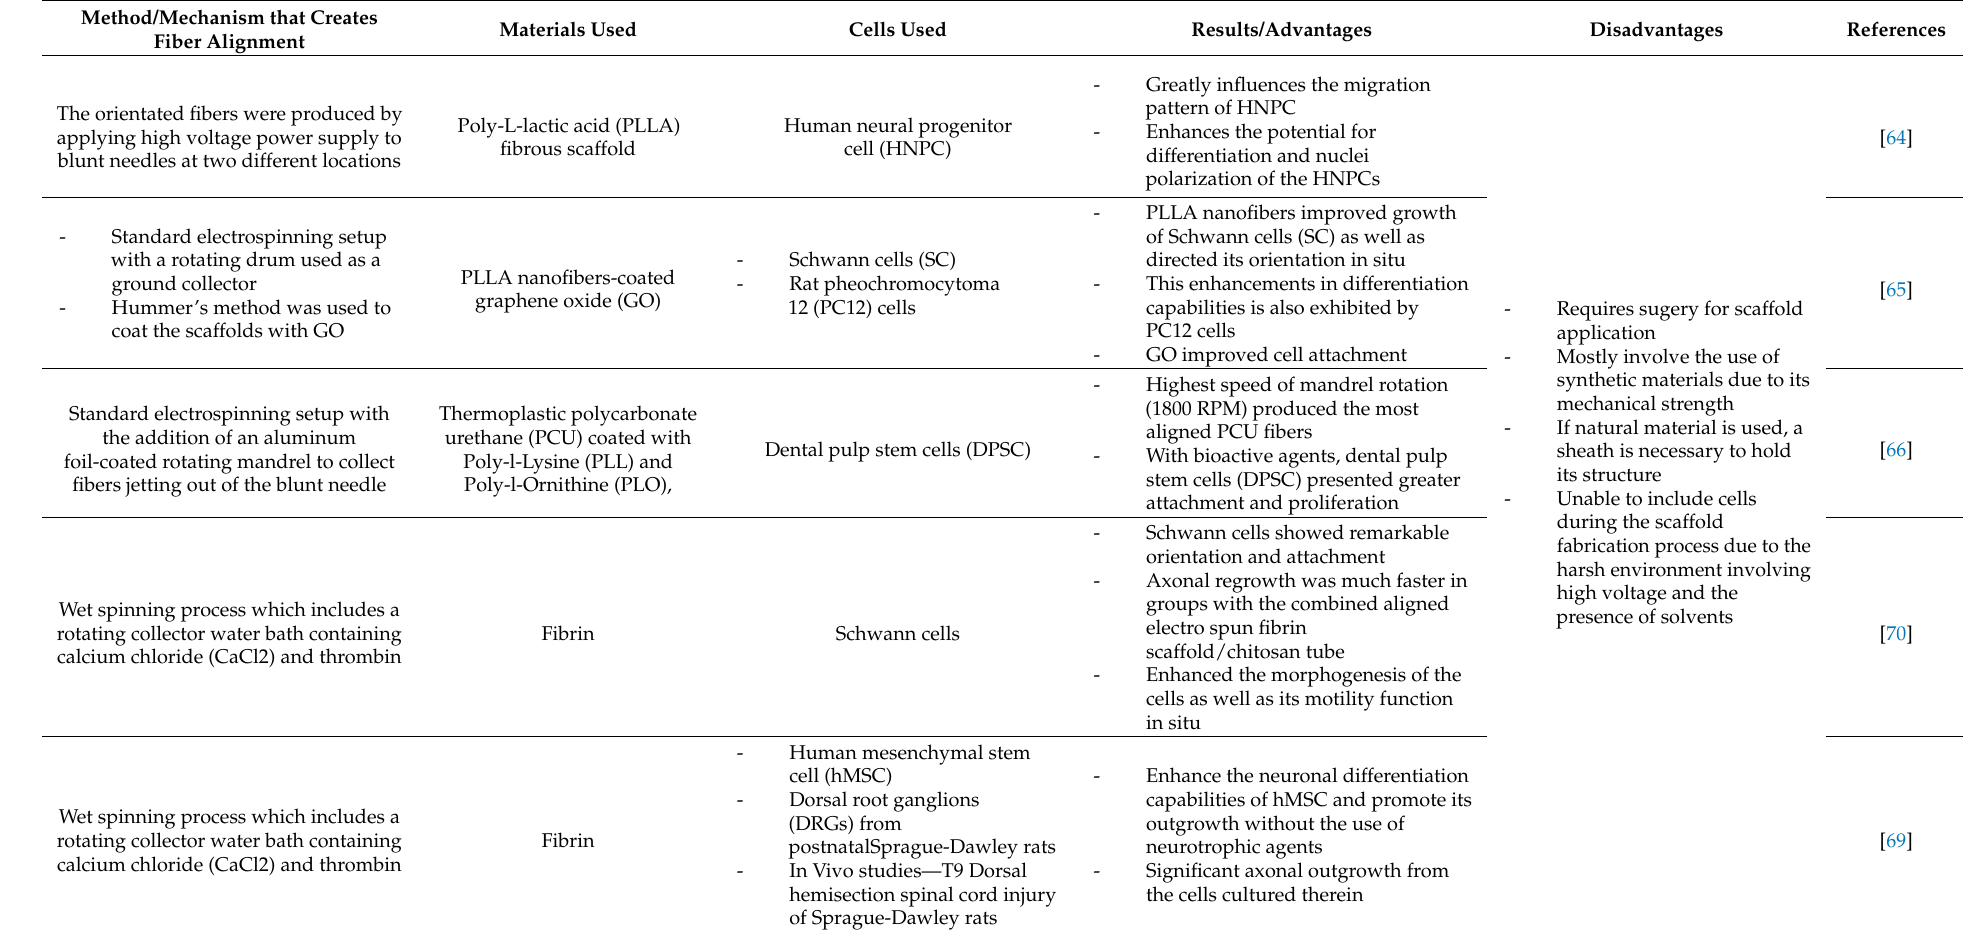
Table 1. Summary of modified electrospinning methods used to produce NTE